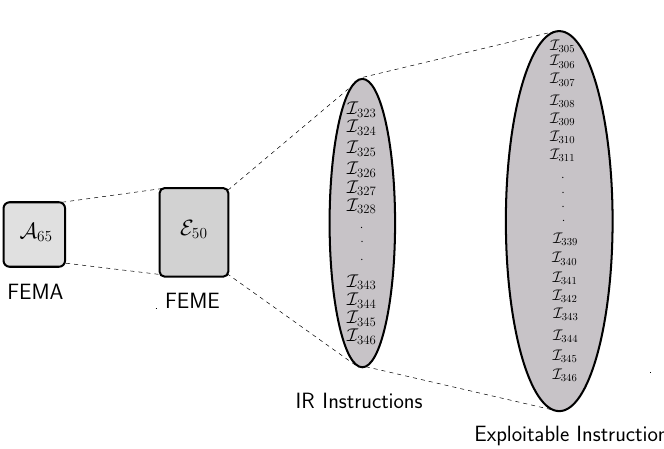
Figure 4: The Fault Mapping of FEDS determines mapping from the FEMA to FEME . Fault Evaluation maps FEME to corresponding IR Instructions and also determine the all the exploitable instructions, i.e. instructions that can corrupt the output of program expressions that are present in FEME